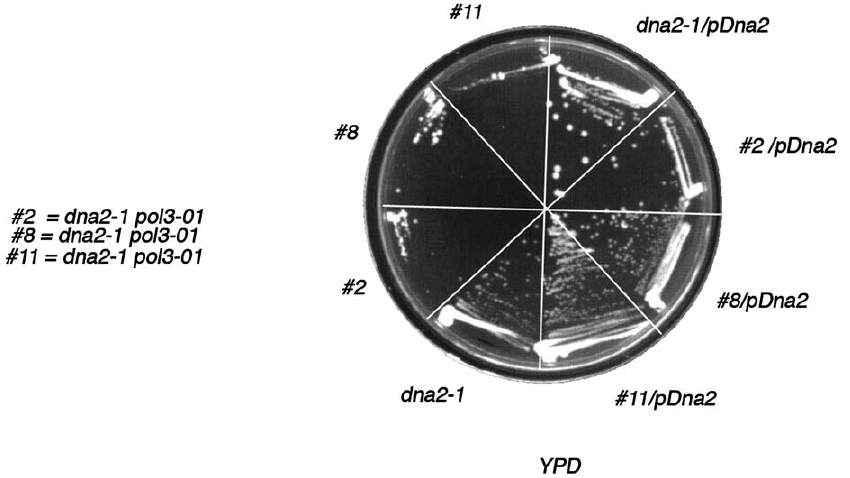
Figure 4. Synthetic Lethality Between dna2 and pol3–01 Strain W303 dna2–1 carrying a TRP1 CEN3 DNA2 plasmid was transformed with an integrating URA3 pol3–01 plasmid [120] cut with BamH1. The transformants were streaked on 5-FOA medium to excise the WT POL3 gene and identify clones with the pol3–01 mutation. Three transformants carrying the pol3–01 mutation (isolates 2, 8, and 11) were restreaked on YPD medium containing 2-amino-5-fluorobenzoic acid (FAA), which selects for strains that have lost the DNA2 TRP1 –containing plasmid [121]. Three dna2–1 pol3–01 colonies showing some residual growth on the FAA plates were restreaked on YPD-containing medium. The same three isolates of dna2–1 pol3–01 but containing the DNA2 TRP plasmid, i.e., that had not been grown in the presence of FAA, are shown as controls, as indicated. DOI: